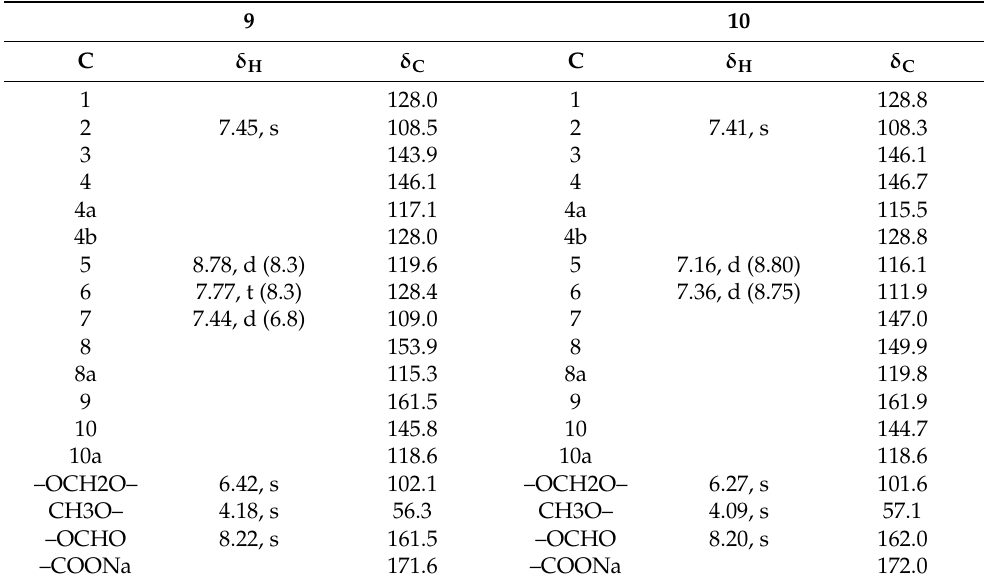
Table 1. 1 H (500 MHz) and 13 C NMR data (125 MHz) of compounds 9 and 10 (in DMSO- d 6 , δ in ppm, J in